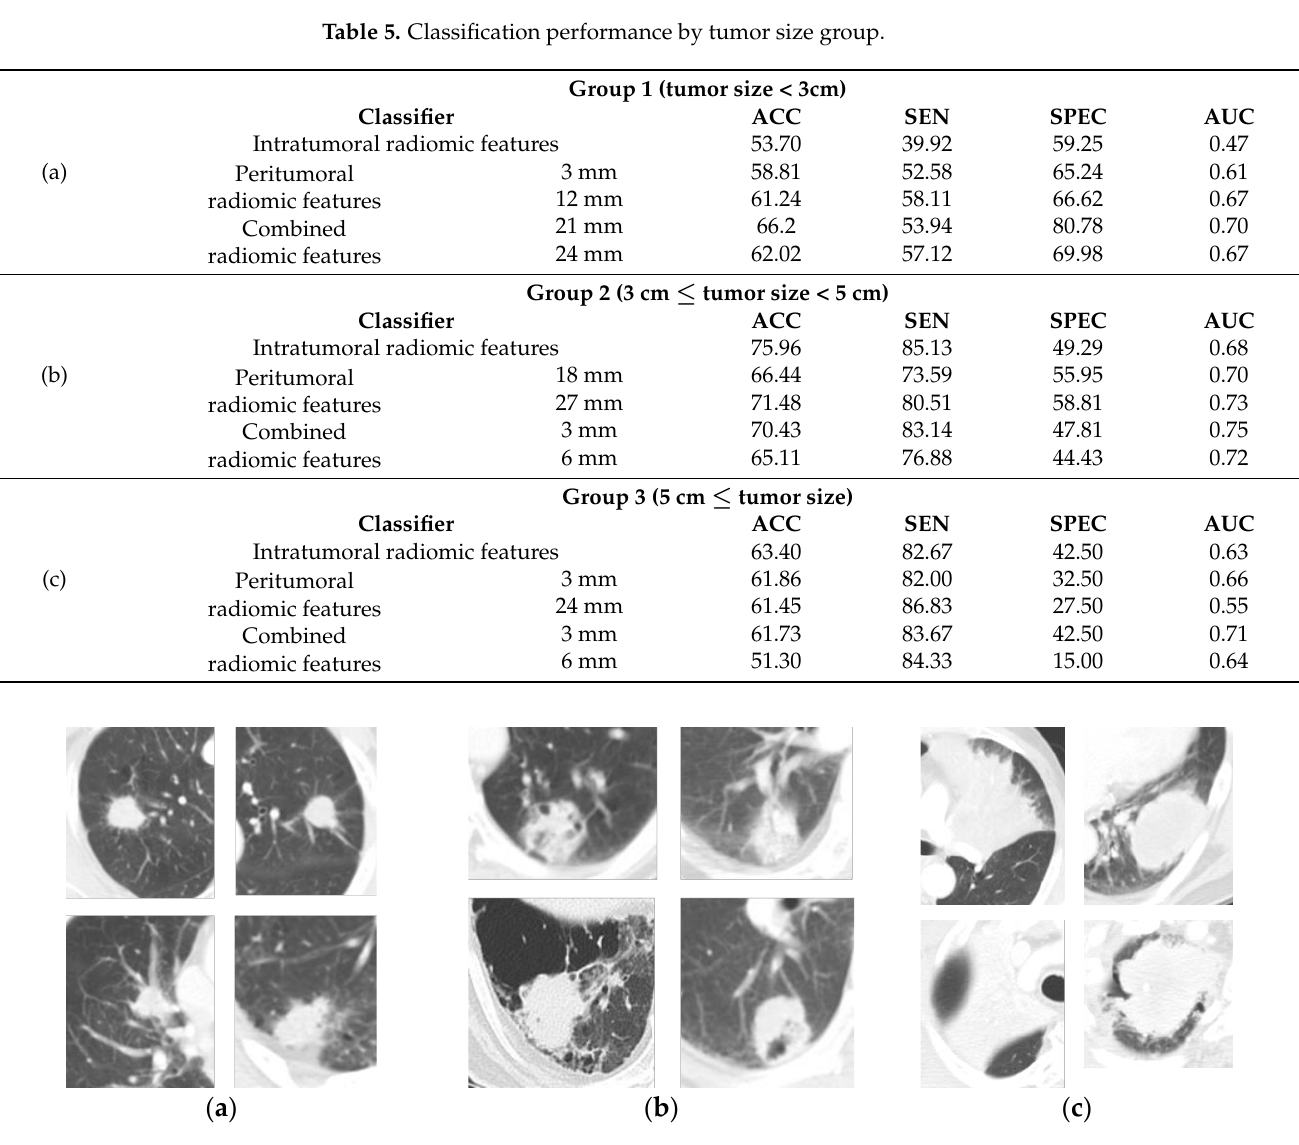
Figure 7. Appearance of lung tumors according to tumor size groups on CT images: ( a ) Group 1; ( b ) Group 2; ( c ) Group 3.